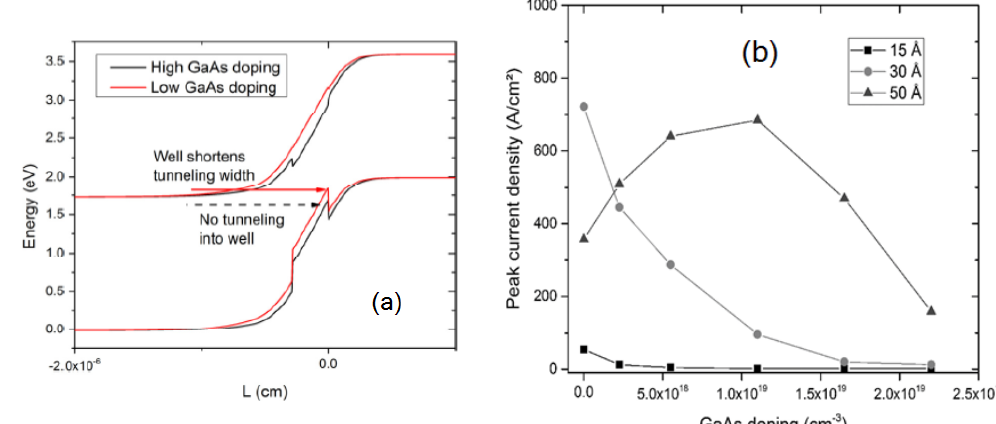
Figure 6. ( a ) Band diagram for structure incorporating a GaAs quantum well at the junction [18] and ( b ) Peak tunneling current range for various In x Ga 1 − x P:Te/GaAs:Te/Al 0.6 Ga 0.4 As:C tunnel junction architectures with GaAs:Te interfacial layer thickness ranging from 15 Å to 50 Å